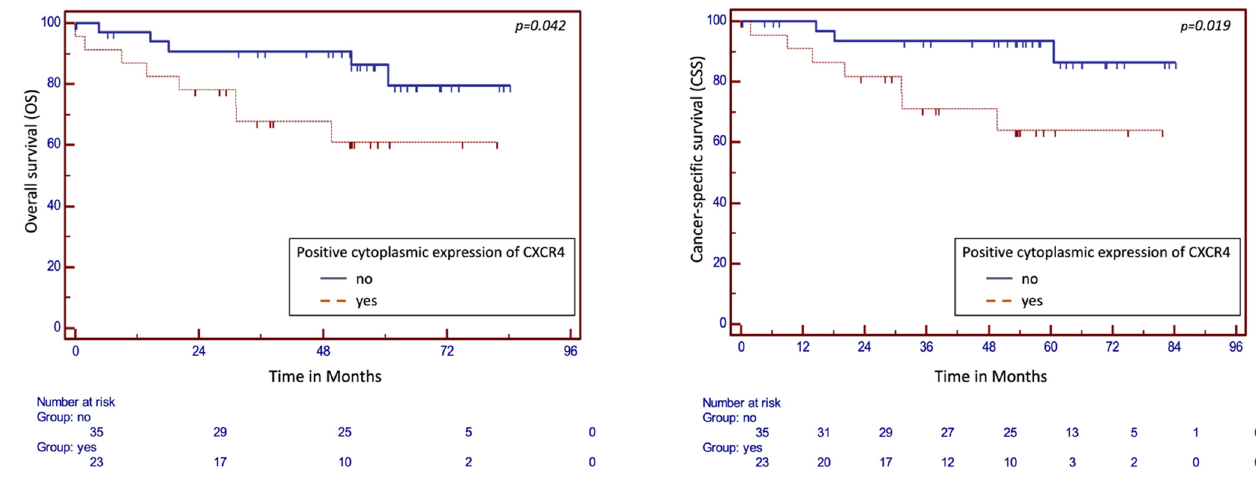
Figure 5. Kaplan–Meier analysis for cohort n 1 : Overall survival (OS) in dependence of positive cytoplasmic CXCR4 expression. Cancer-specific survival (CSS) in dependence of positive cytoplasmic CXCR4 expression.